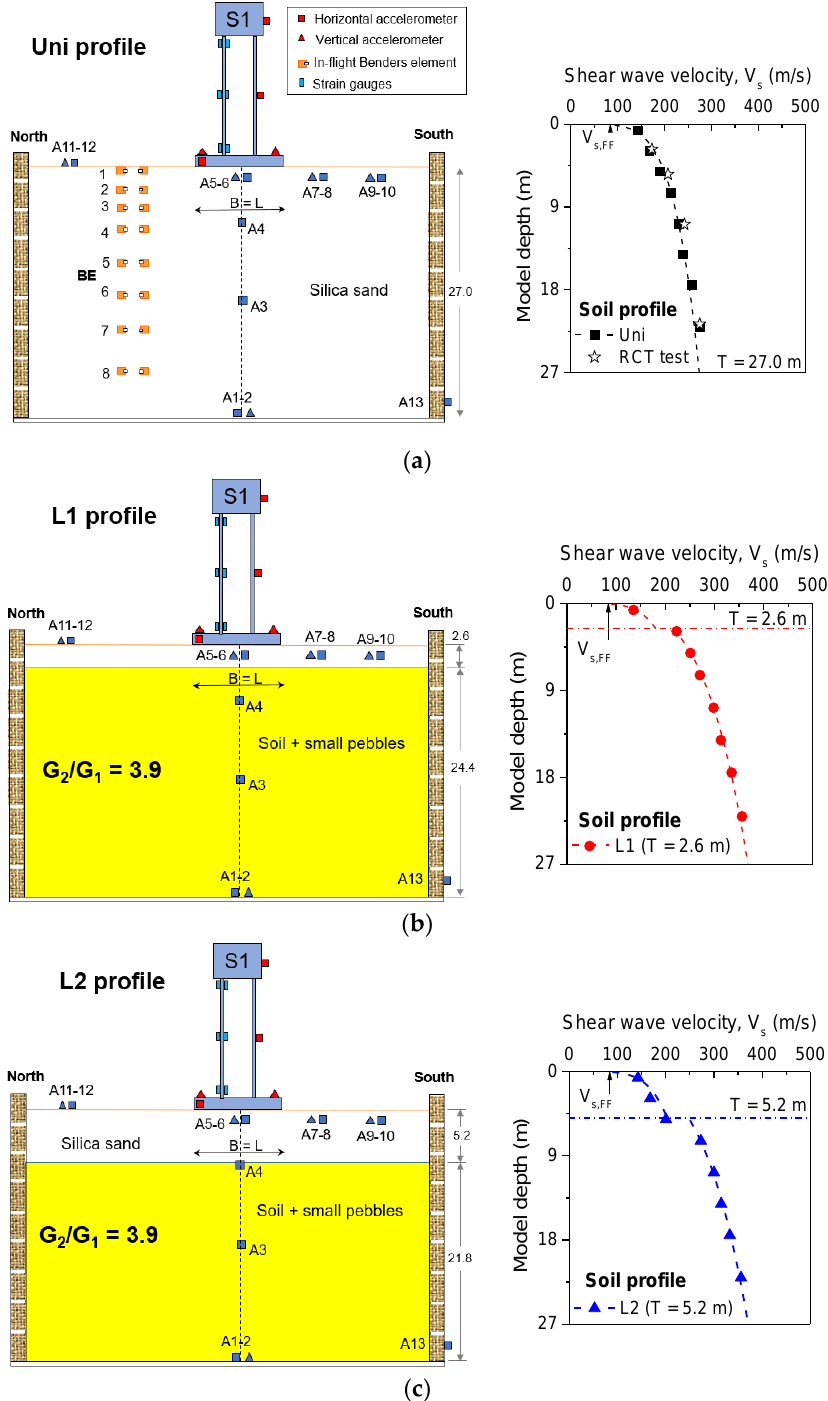
Figure 1. Three soil profiles with an in-flight bender element, accelerometer (left), and shear wave velocity (V s ) profile (right) at ( a ) Uni: uniform ground, ( b ) L1: ground with 2.6 m soft above layer, and ( c ) L2: ground with 5.2 m soft above layer. Unit: m.